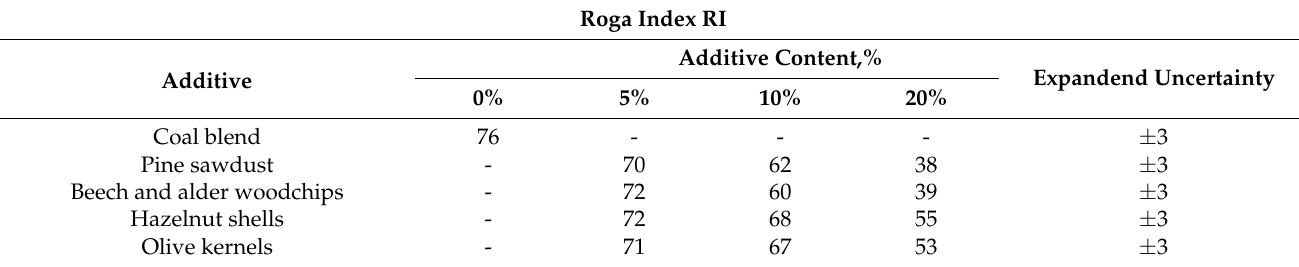
Table A6. The influence of biomass additive on RI